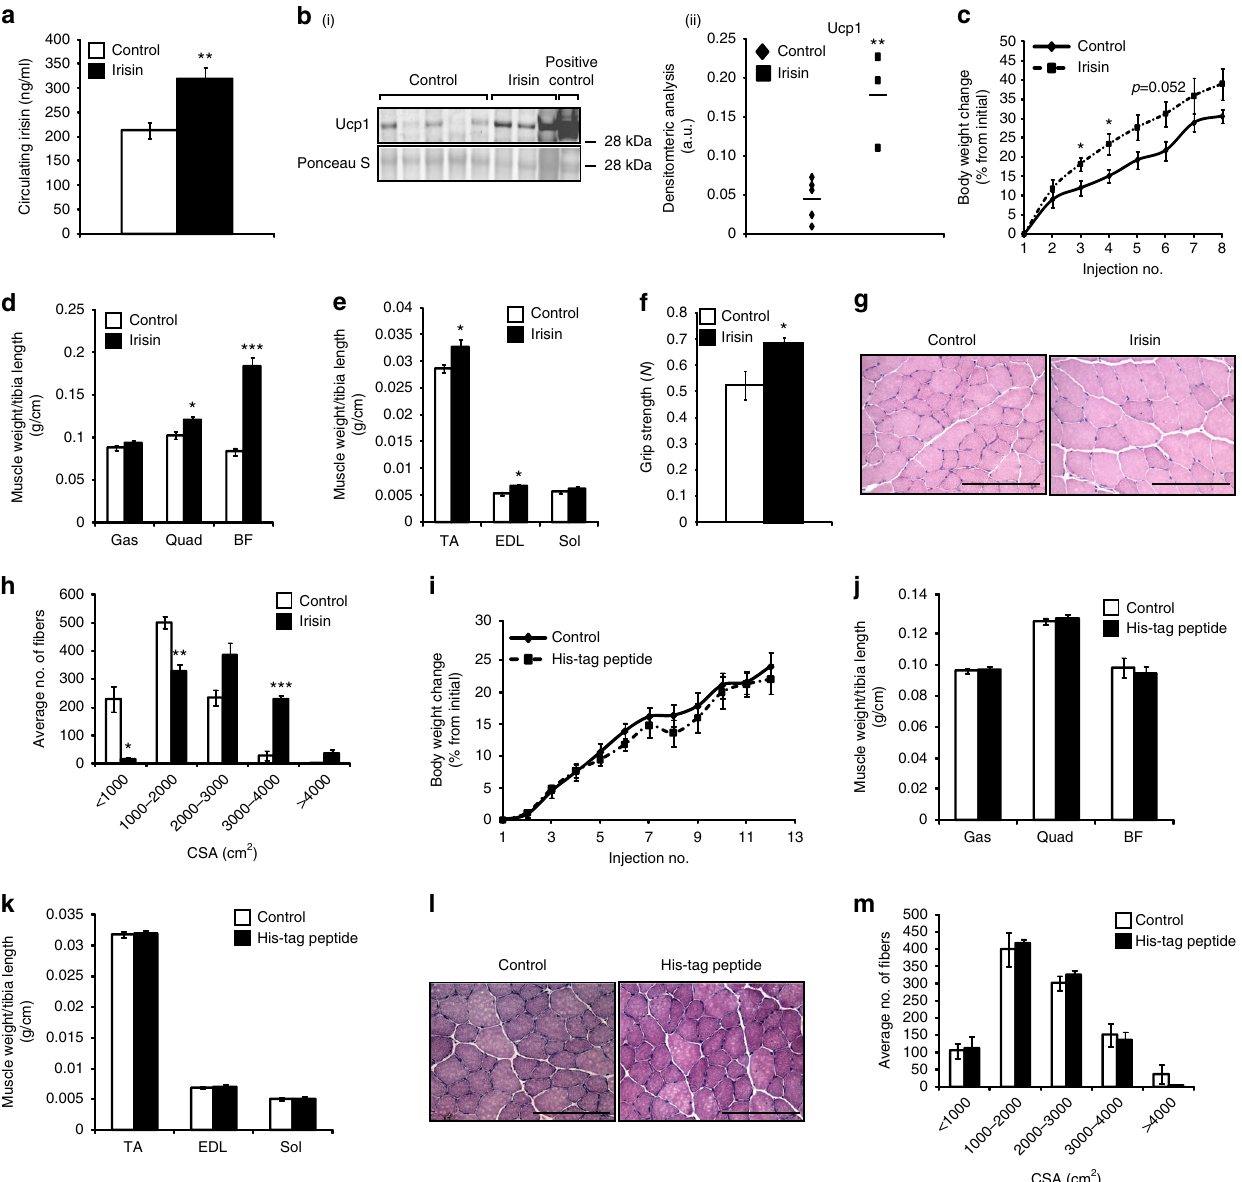
Fig. 4 Irisin improves protein synthesis and reduces protein degradation. a Graph showing levels of irisin circulating in serum of mice injected with DB (control) or recombinant irisin ( n = 5 mice for DB-injected group and n = 6 mice for irisin-injected group). b (i) IB analysis of Ucp1 levels. The levels of Ponceau S were assessed as a loading control. b (ii) Graph showing densitometric analysis of Ucp1 levels in arbitrary units (a.u), normalized to Ponceau S. Brown adipose tissue was used as a positive control to detect Ucp1 ( n = 5 mice for DB-injected group and n = 3 mice for irisin-injected group). c Graph showing body weight change (% from initial) in mice injected with either DB or irisin protein. Graphs displaying d Gas, Quad, and BF, and e TA, EDL, and Sol muscle weights of mice injected with DB (control) or irisin. All hindlimb muscle weights were normalized to tibia length. f Graph showing the grip strength of mice (in newton; N) injected with DB (control) or irisin ( n = 5 mice for DB-injected group and n = 4 mice for irisin-injected group). g Representative images of H&E-stained TA muscle from mice injected with DB (control) or irisin. Images were captured using a ×20 objective. Scale bar represents 100 μ m. h Graph showing the distribution of TA myo fi ber CSA in mice injected with DB (control) or irisin ( n = 3 mice per group). i Graph showing body weight change (% from initial) in mice injected with either DB (control) or His-tagged peptide. Graphs displaying j Gas, Quad, and BF, and k TA, EDL, and Sol muscle weights of mice injected with DB (control) or His-tagged peptide. All hindlimb muscle weights were normalized to tibia length ( n = 5 mice for each treatment group). l Representative images of H&E-stained TA muscle from mice injected with DB (control) or His-tagged peptide. Images were captured using a ×20 objective. Scale bar represents 100 μ m. m Graph showing the distribution of TA myo fi ber CSA in mice injected with DB (control) or His-tagged peptide ( n = 3 mice per treatment group). Error bars represent mean ± SEM. Student ’ s t -test was performed for all relevant fi gure panels. Signi fi cance is indicated with * p < 0.05, ** p < 0.01 and *** p <